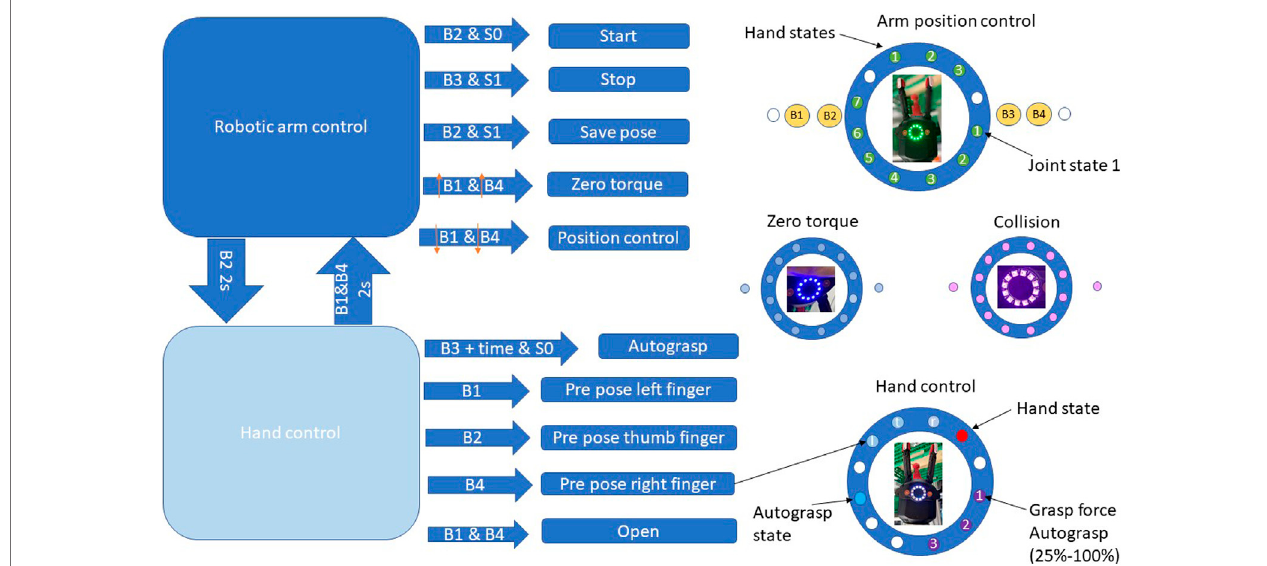
FIGURE5| Sensorsensibilitydependingon fi ngerstiffness. (A) Contactforcedependingonstiffnessand fi ngervelocityfortheCLASH3Fthumb. (B) Testbedwith the thumb, and a fi xed resistive sensor array.